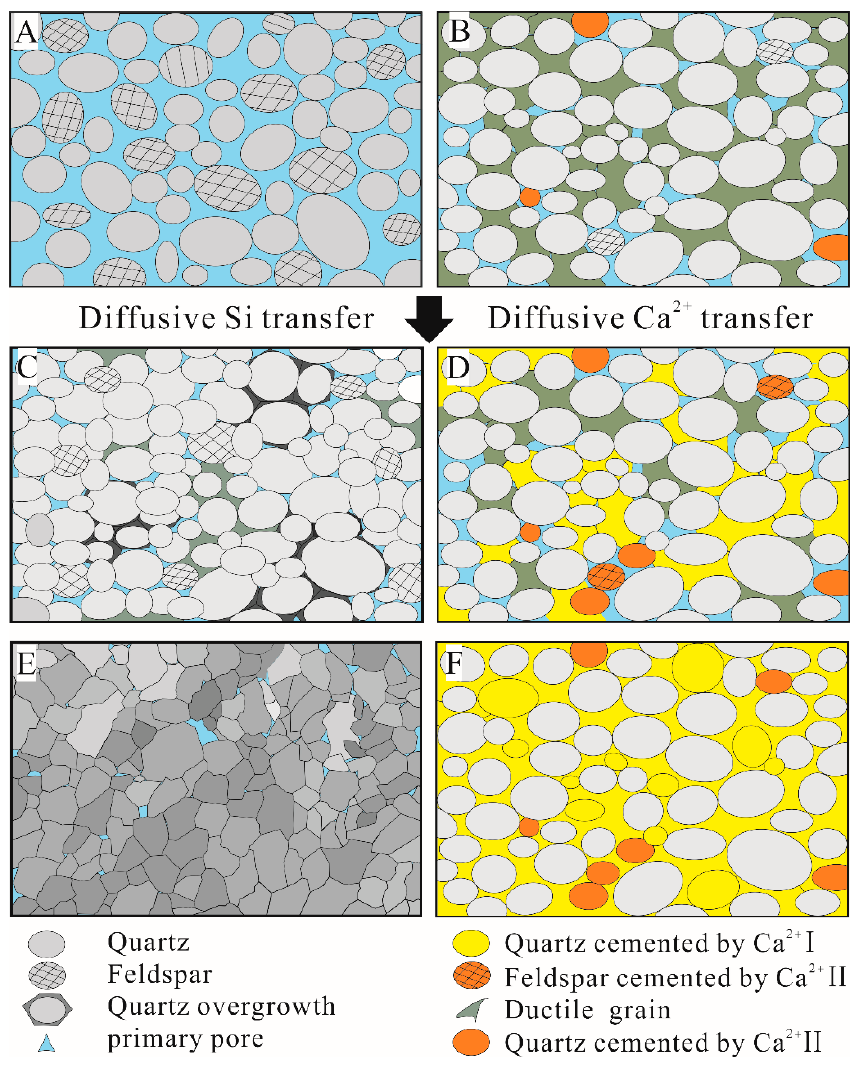
Figure 8. The whole densification process model of lithic quartz sandstone. ( A ) the grain distribution of lithic quartz sandstone before diagenesis; ( B ) the rock fragments were deformed to fake matrix by compaction during early diagenetic stage; ( C ) the quartz grains developed siliceous cements and most of the fake matrix or rock fragments were translated to the formation fluid rich in Si 2+ ; ( D ) some of the fake matrix or rock fragments in ( B ) were replaced by Ca 2+ ; ( E ) quartz grains in ( C ) further grew to a more tight form; ( F ) most of the grains except quartz were cemented and replaced by calcite cementation.